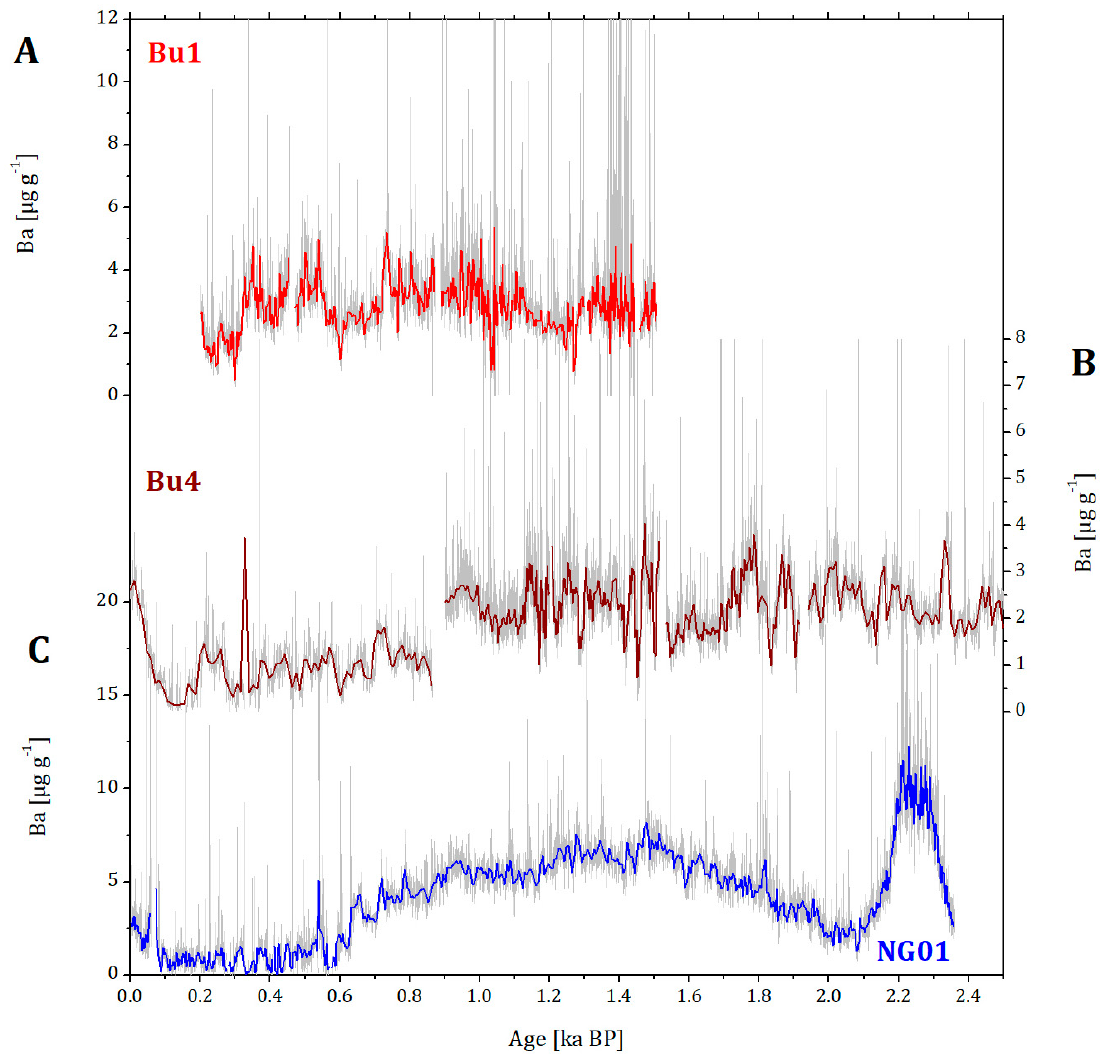
Figure 6. Ba concentration of the two speleothems Bu1 ( A ) and Bu4 ( B ) from Bunker Cave as well as NG01 ( C ) from the Herbstlabyrinth cave system. The data were smoothed with a 10-point (NG01) or 20-point (Bu1 and Bu4) running median. The raw data are shown in light grey and the respective running medians as colored lines.